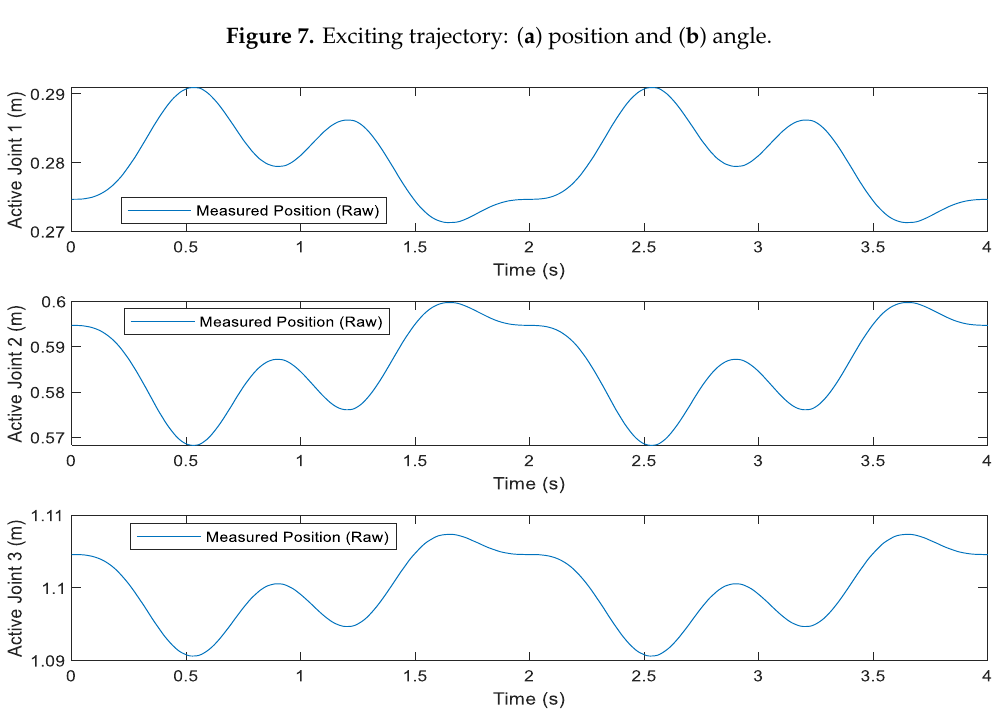
Figure 8. Raw measured active joint positions.